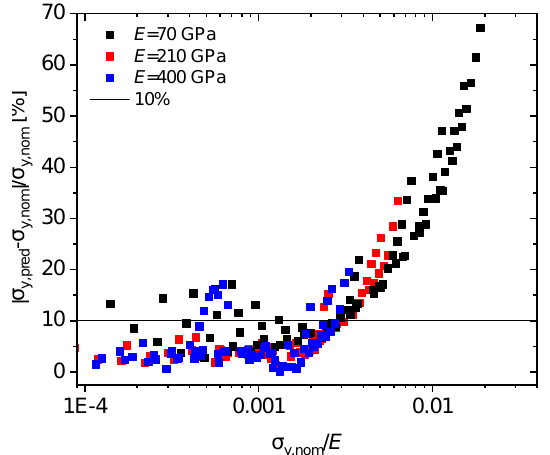
Figure 4. Error percentage of yield stress predicted by the displacement-based formula (Equation (3)), when applied to deflection data. Higher error percentages are noted for σ y,nom / E >